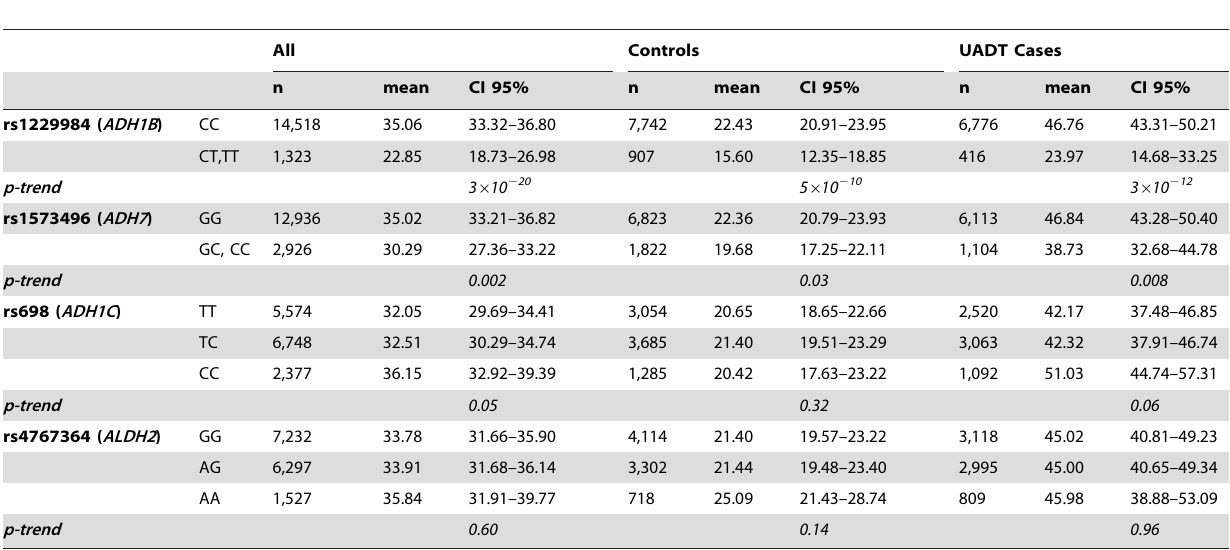
Table 2. Association between rs1229984, rs1573496, rs698, rs4767364, and drinking intensity in ever drinkers expressed as mean of ml of ethanol consumed per day.